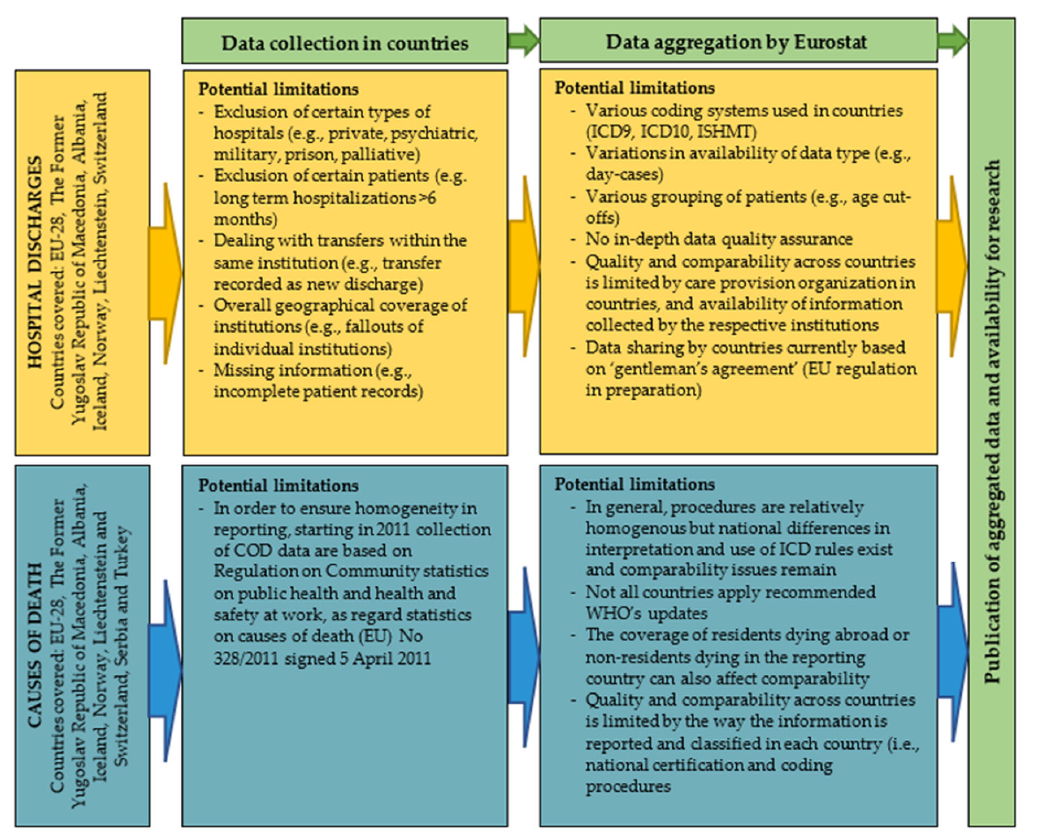
Figure 1. Potential causes of variation of rates of TBI-related deaths, YLLs and hospital discharges in the pediatric and adolescent populations of European countries in 2014 between the analyzed countries. Source: Eurostat hospital discharge dataset metadata [16] and Eurostat Causes of deaths dataset metadata [17]. COD: Causes of deaths, EU: European Union, ICD: International classification of diseases, WHO: World Health Organization; ICD9: International classification of diseases 9th version, ICD10: International classification of diseases 10th version, ISHMT: International shortlist for hospital morbidity